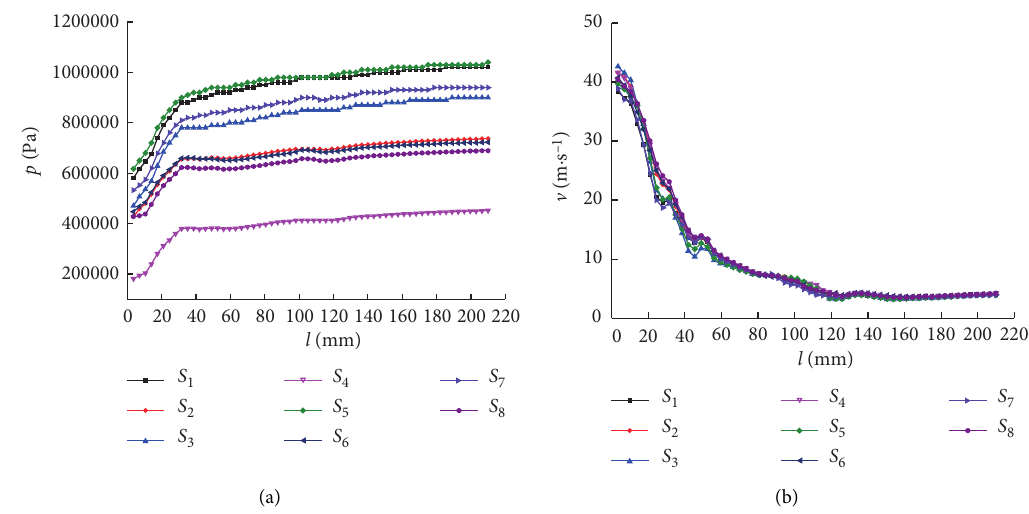
Figure 12: Pressure and velocity distribution on central axis of collecting pipe. (a) Pressure distribution. (b) Velocity